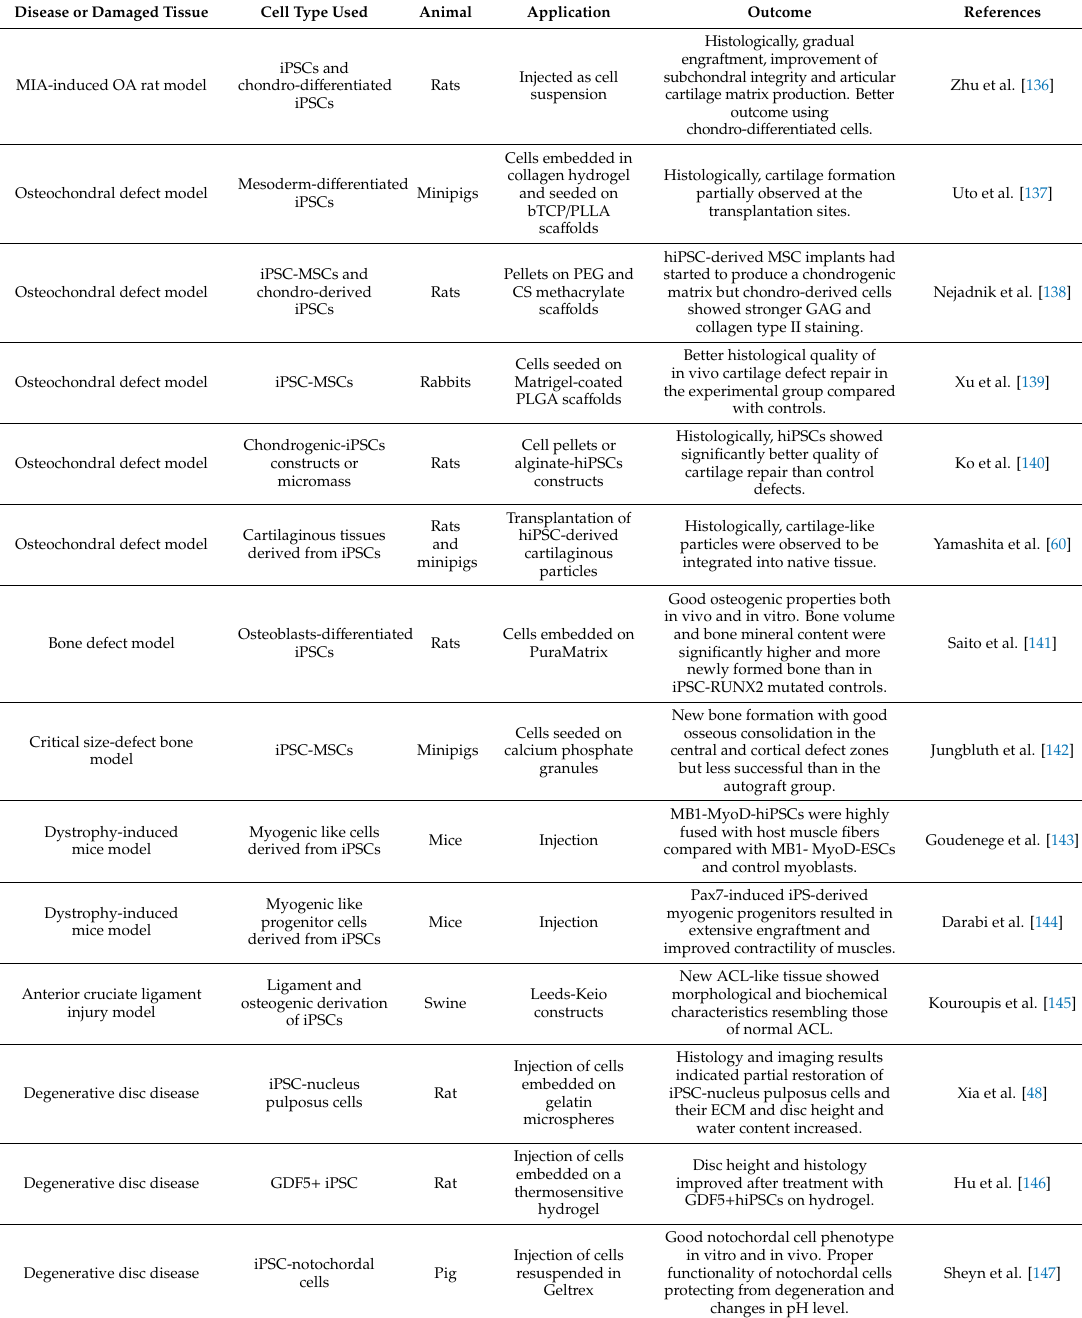
Table 2. Summary of musculoskeletal preclinical repair models using